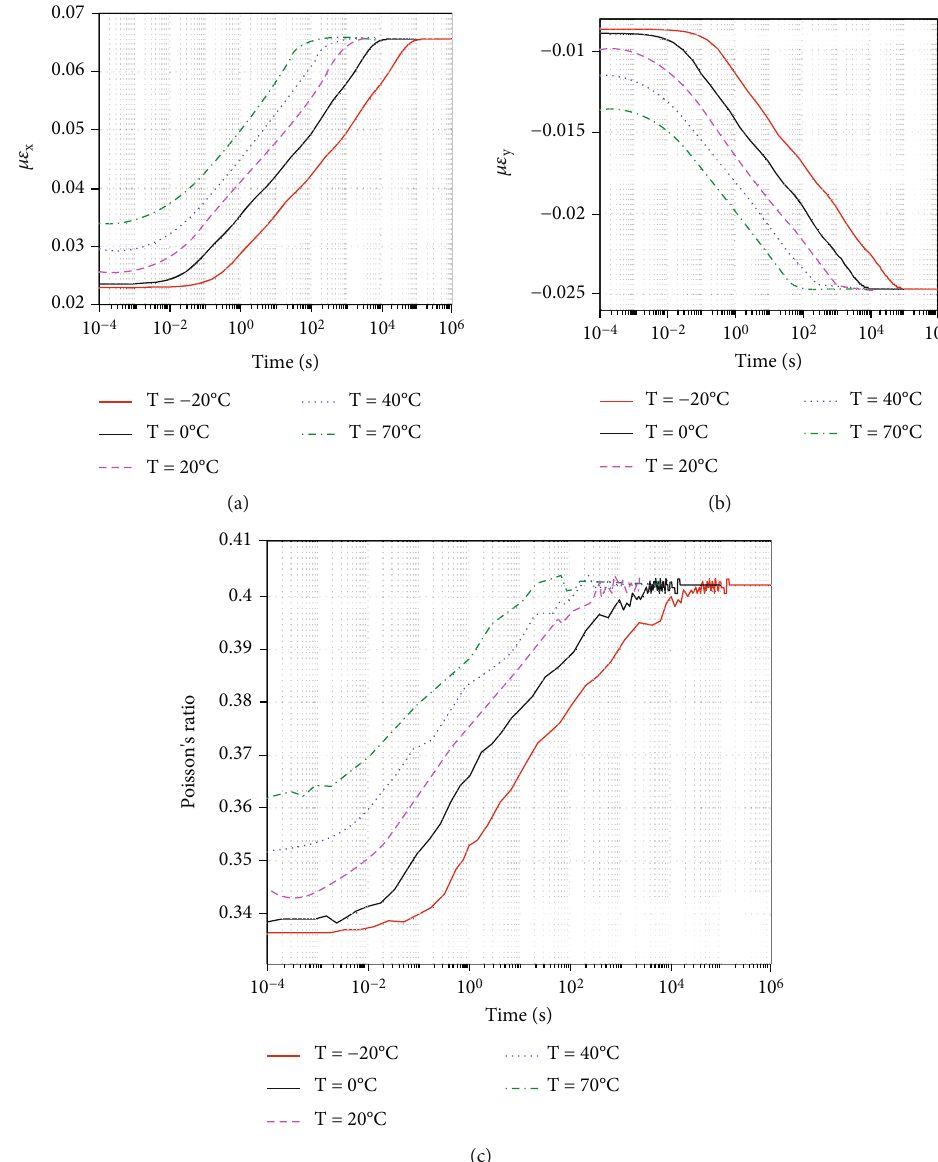
Figure 16: The curves of (a) longitudinal strain, (b) transverse strain, and (c) Poisson ’ s ratio versus time under di ff erent loading temperatures when cohesive strength equals to